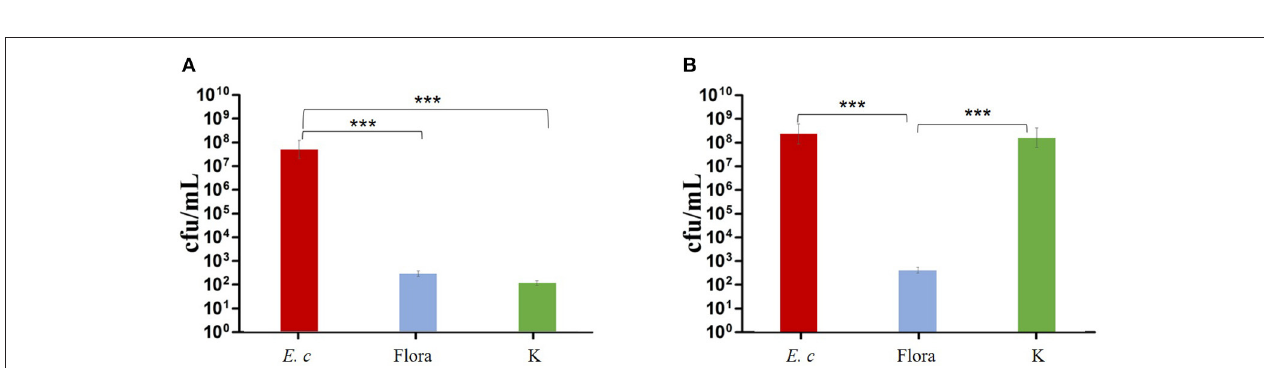
FIGURE 10 | Effects of phage and kanamycin sulfate (10 µ g/ml) on E. coli colony-forming units. (A) Effects of phage Flora and kanamycin sulfate (10 µ g/ml) on E. coli (inoculated at a concentration of 4 ‰ ) cultured for 24h. (B) Effects of phage Flora and kanamycin sulfate (10 µ g/ml) on E. coli (inoculated at rate of 4 ‰ ) after first being cultured for 12h, followed by phage Flora and kanamycin sulfate (10 µ g/ml) addition and culturing for 12h. *** p <